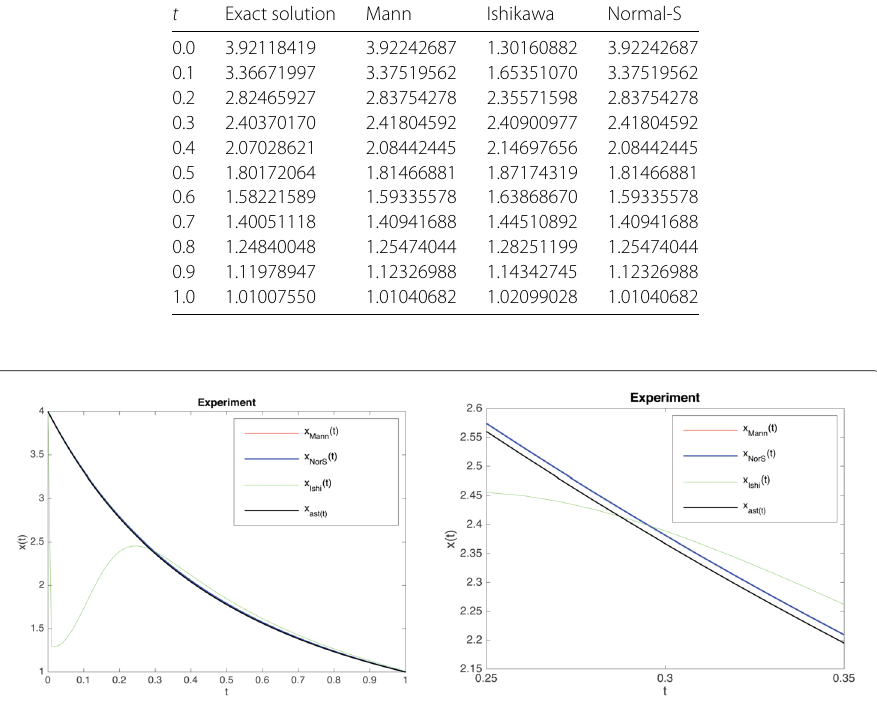
Figure 1 The convergence step of sequence { x n } with α n = 0.1 + 0.000001